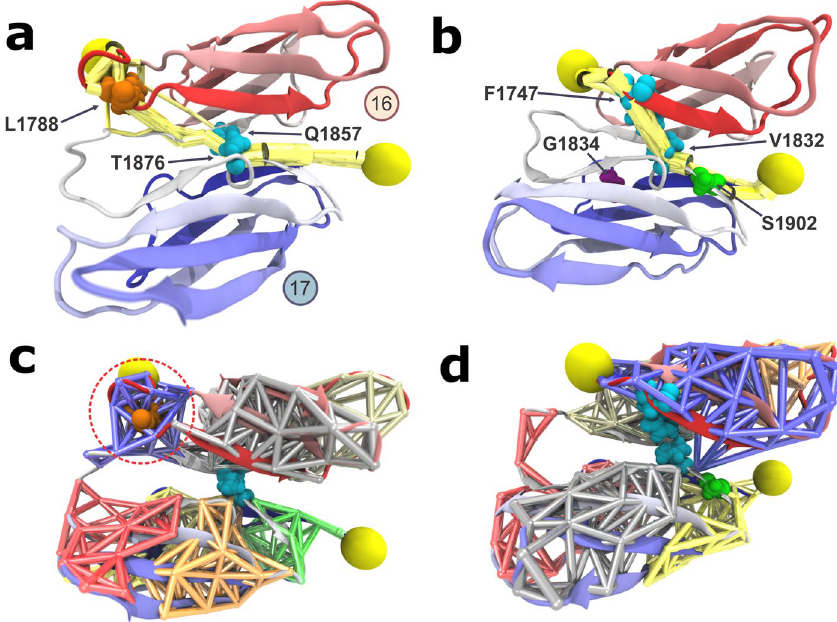
Figure 6. Network analysis and force propagation through FLN 16-17. When force is propagated through a molecule, soft degrees of freedom will be stretched out along the path of force propagation, while stiff degrees become more important for the dynamics of the system. Consequently, paths with high correlation of motion describe the paths along which force propagates through the system. ( a ) The calculated force propagation pathway shows that residue L1788, associated to FMD, is a main node in the force propagation pathway (yellow) in FLNa16-17. The analyses also revealed the strongest correlation between the internal motion of domains 16 and 17 occur between residues Q1857 and T1876. ( b ) The analyses revealed that in FLNb from LS associated residues G1834 is not part of the force propagation pathway (yellow) while S1902 contributes to the pathway but it is not a main node. ( c ) Community analysis reveals the highly correlated regions within the protein complex. It shows that L1788 is an important part of one of the network communities in FLNa (marked by the red dashed circle). ( d ) For FLNb, the mutation sites G1834 and S1902 are not shown as main nodes in the